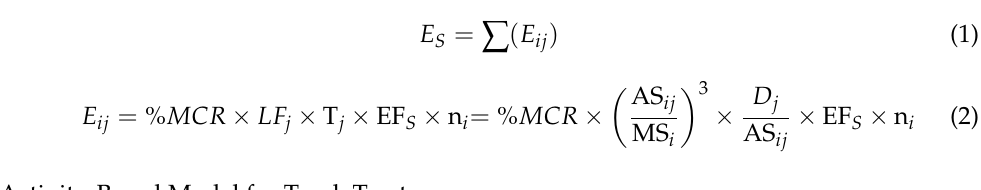
Table 2. Notations for parameters, variables and functions.